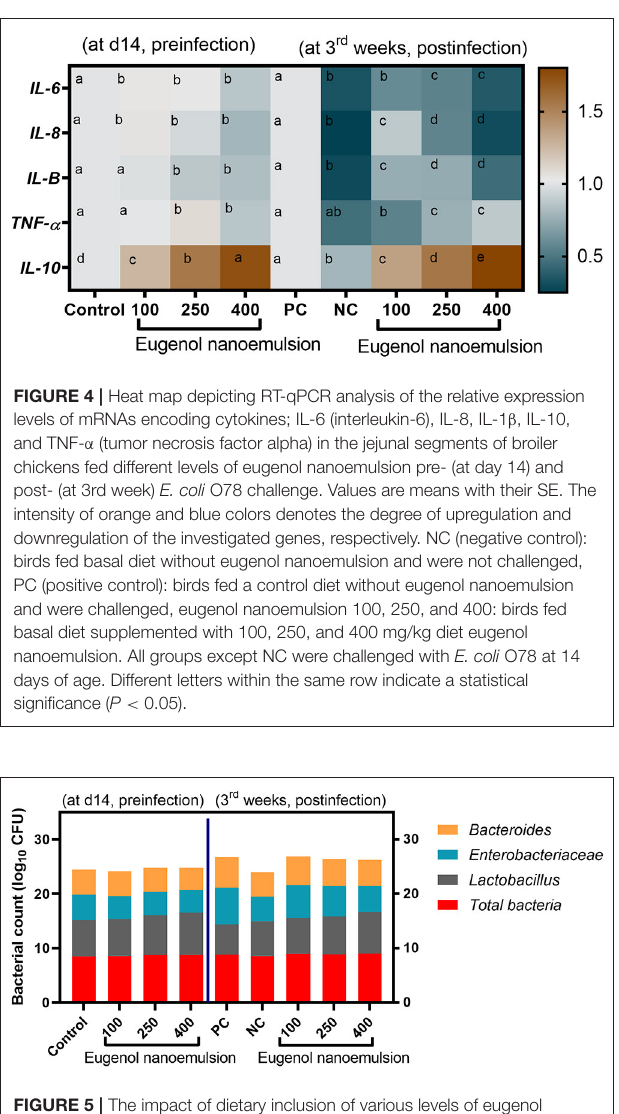
FIGURE 5 | The impact of dietary inclusion of various levels of eugenol nanoemulsion on the populations (log 10 CFU) of total bacteria, Lactobacillus , Enterobacteriaceae, and Bacteriods as was estimated by qPCR assay in the cecal digesta of broiler chickens pre- (at day 14) and post- (at 3rd week) E. coli O78 challenge. Values are means with their SE. NC (negative control): birds fed basal diet without eugenol nanoemulsion and were not challenged, PC (positive control): birds fed a control diet without eugenol nanoemulsion and were challenged, eugenol nanoemulsion 100, 250, and 400: birds fed basal diet supplemented with 100, 250, and 400 mg/kg diet eugenol nanoemulsion. All groups except NC were challenged with E. coli O78 at 14 days of age.